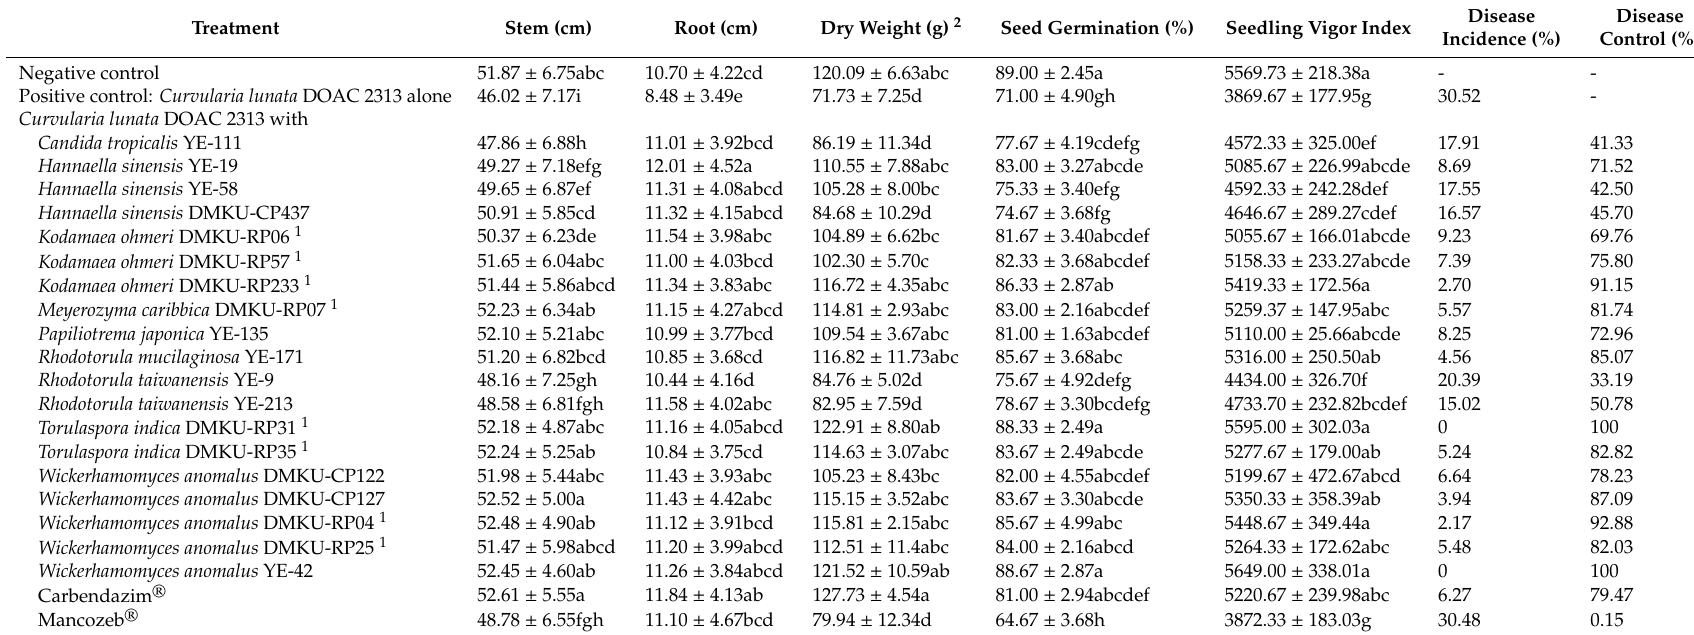
Table 4. Control of rice seedling rot disease caused by Curvularia lunata DOAC 2313 by antagonistic yeasts and chemical fungicides.